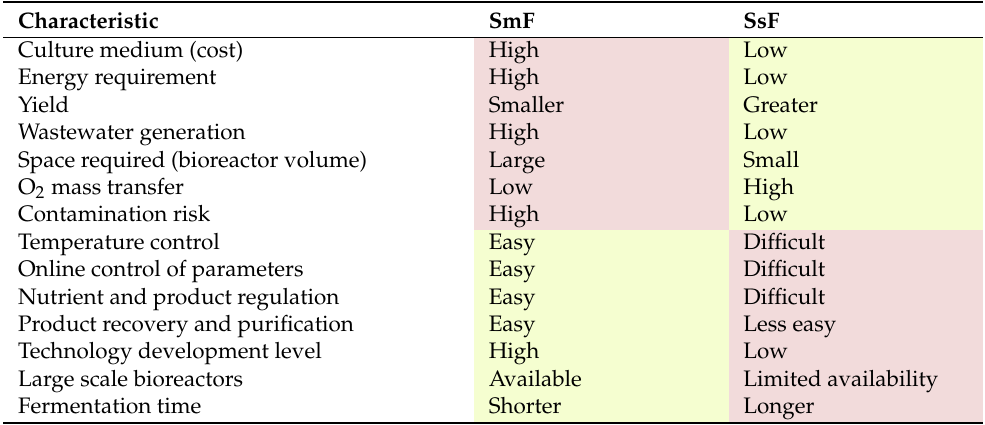
Table 1. Comparison between SsF and SmF features as described by several authors. The background colour indicates an advantage (green) or disadvantage (red) [1,7,15,17,28–31]. Characteristic SmF SsF Culture medium